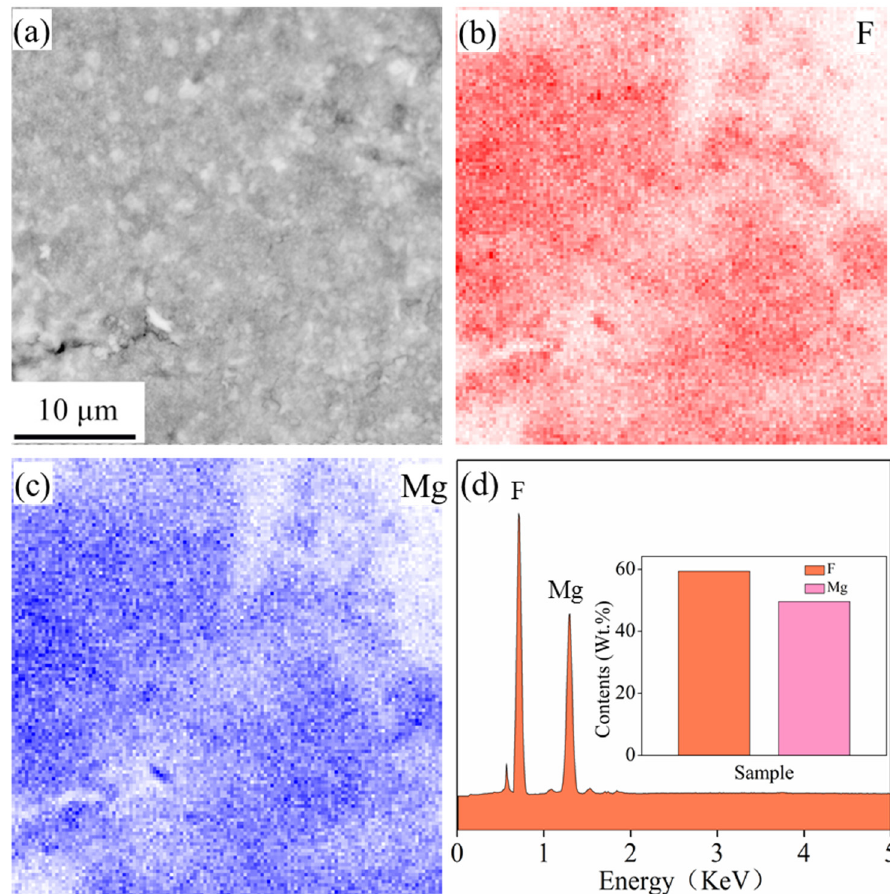
Figure 3. The energy dispersive (EDS) map analysis of the surface of U-treatment Mg alloy at the frequency of 28 kHz: ( a ) SEM surface, ( b ) F distribution, ( c ) Mg distribution, and ( d ) Contents of F and Mg elements.